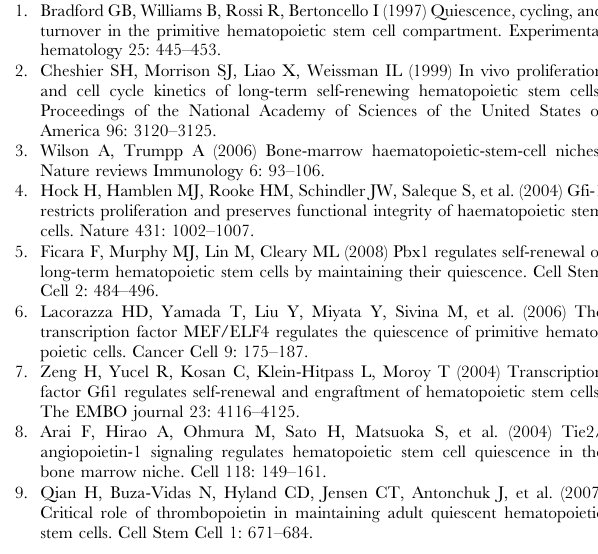
Figure S1 Preferential expression of Meis1 in HSCs.